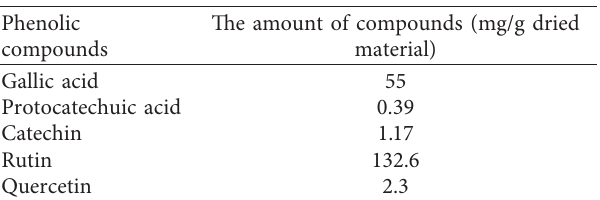
Table 5: The amount of phenolic compounds in the methanolic extract of Pistacia vera L .